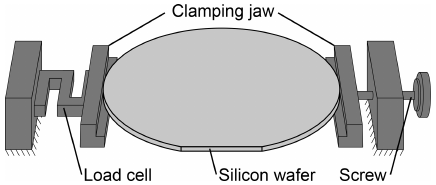
Figure 5. Brazilian disc test for a load along the [011] direc- tion used to determine stress-optical parameters for a (100)-silicon wafer.